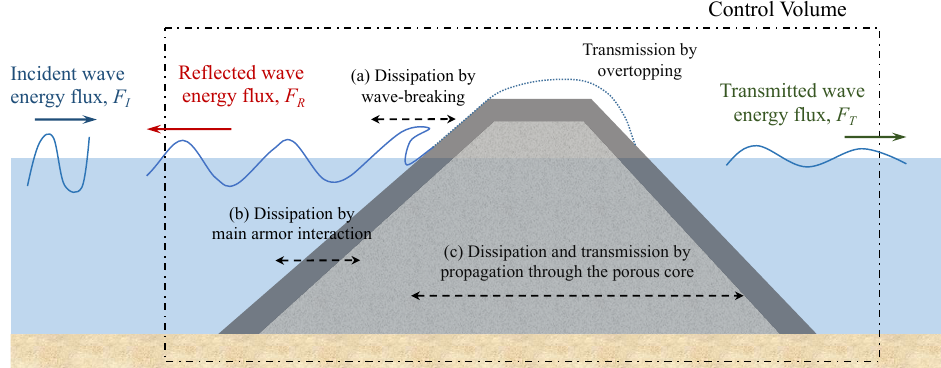
Figure 3. The wave energy transformation by its interactions with a maritime structure. The analysis of the wave energy transformation modes can be achieved by defining a finite control volume (CV) with a unit width and constant depth that includes the structure. The wave energy conservation equation in the control volume is given by F I − F R − F T − D (cid:48) ∗ = 0 [52], with F i , i = I , R , and T being the mean energy flux of the incident, reflected, and transmitted wave trains, respectively; and, D (cid:48) ∗ the mean bulk dissipation.